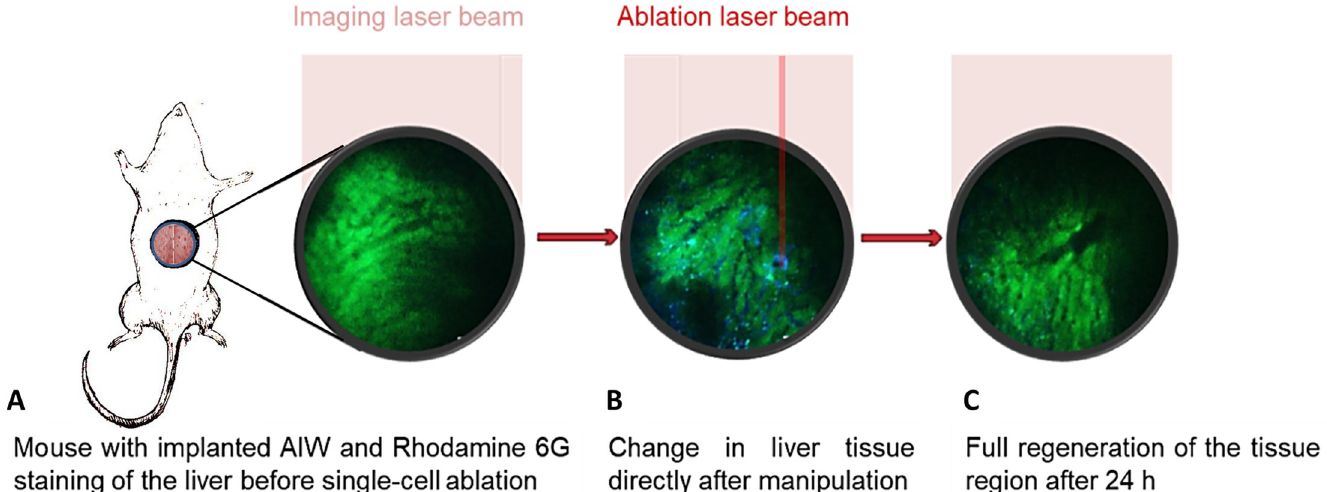
Fig 1. Schematic depiction of the planned procedure: ( A ) Mouse with implanted abdominal imaging window (AIW) and liver directly under the AIW. ( B ) MPM-image of the healthy liver (green: Rhodamine 6G, blue: FITC-Dextran) after application of a targeted femtosecond laser pulse. ( C ) MPM-image of a follow-up analysis of the manipulated